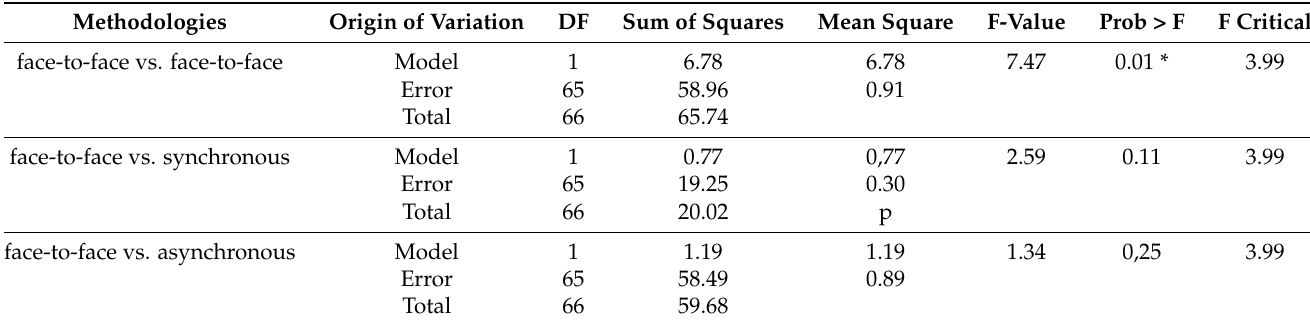
Table 17. ANOVA results for a 0.05 level of significance for the means for the different methodologies per academic year.